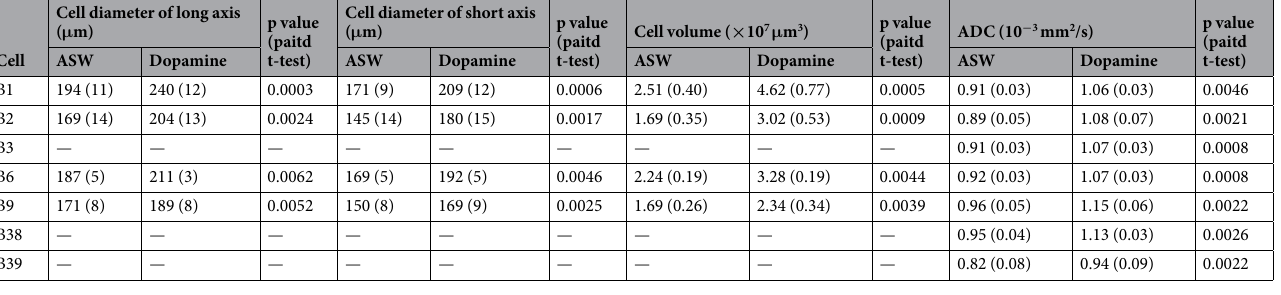
Table 1. ADC values inside neurons, cell diameters, and volume with and without dopamine stimulation. The values were averaged over neurons on both sides of the ganglia in 4 Aplysia for microscopy data and 7 Aplysia for the ADC. The values are showed as Mean ( ± SEM). It was not possible to measure neurons B3, B38, and B39 with optical microscopy as they were located behind neurons B6 and B9.